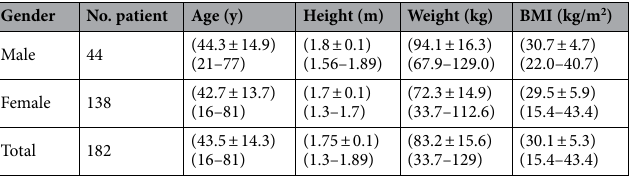
Table 1. Mean, ± Sd and range of patient demographic data in thyroid cancer by using Iodine-131.